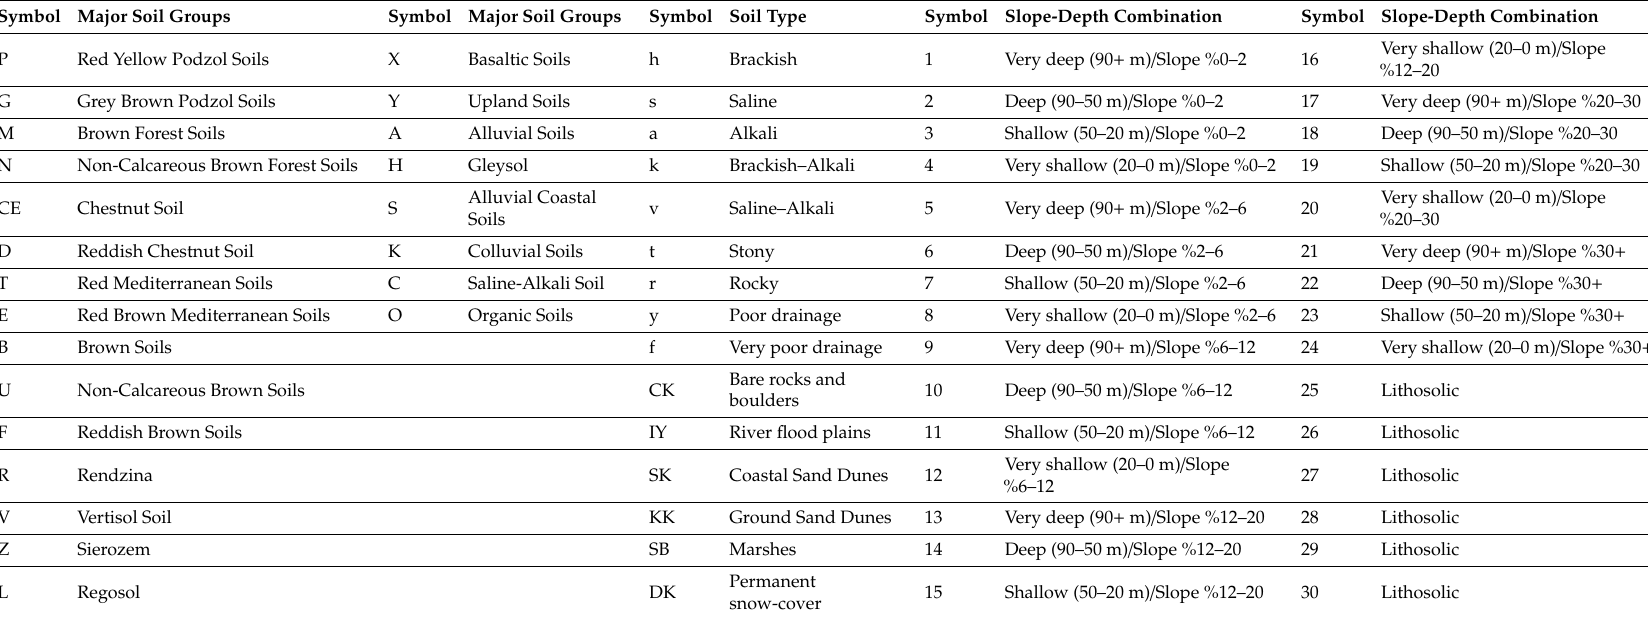
Table A3. Mapping units of major soil groups in Turkey